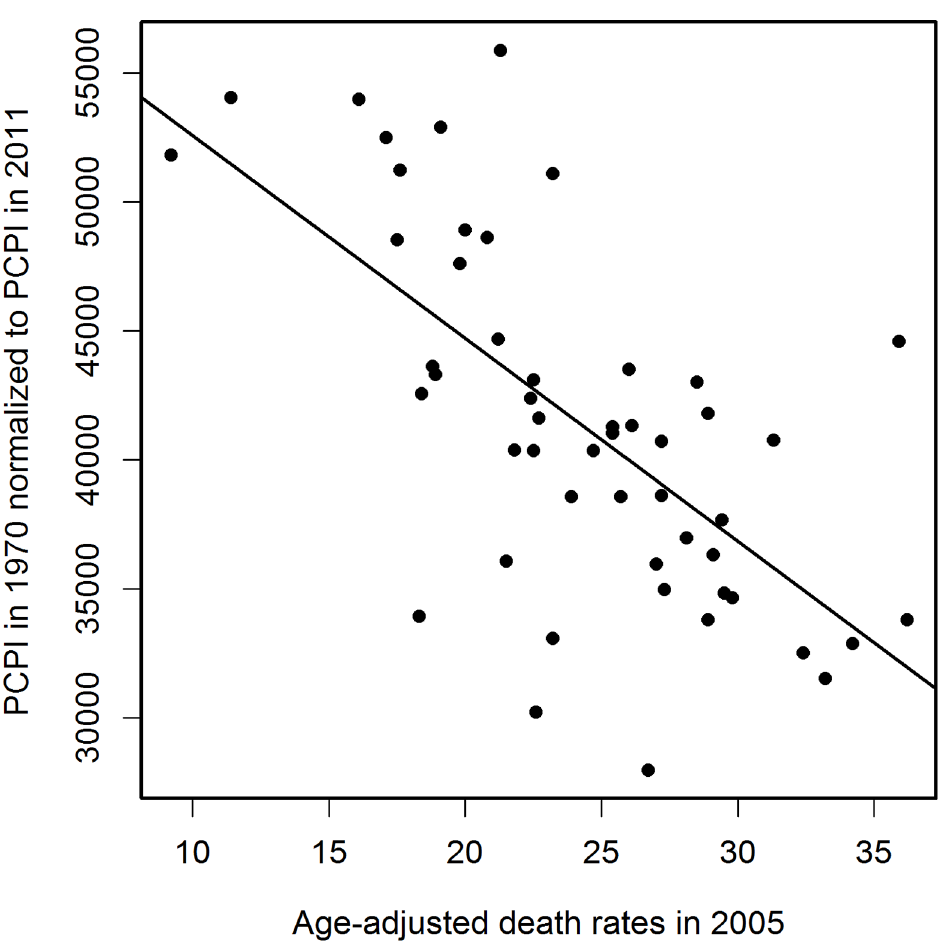
Fig 1. Negative correlation of PCPI in 1970 (in 51 states of the USA) with age-adjusted AD death rates (AADRs) for the respective states in 2005. Death rates are represented by the number of cases per 100 000 population adjusted for age